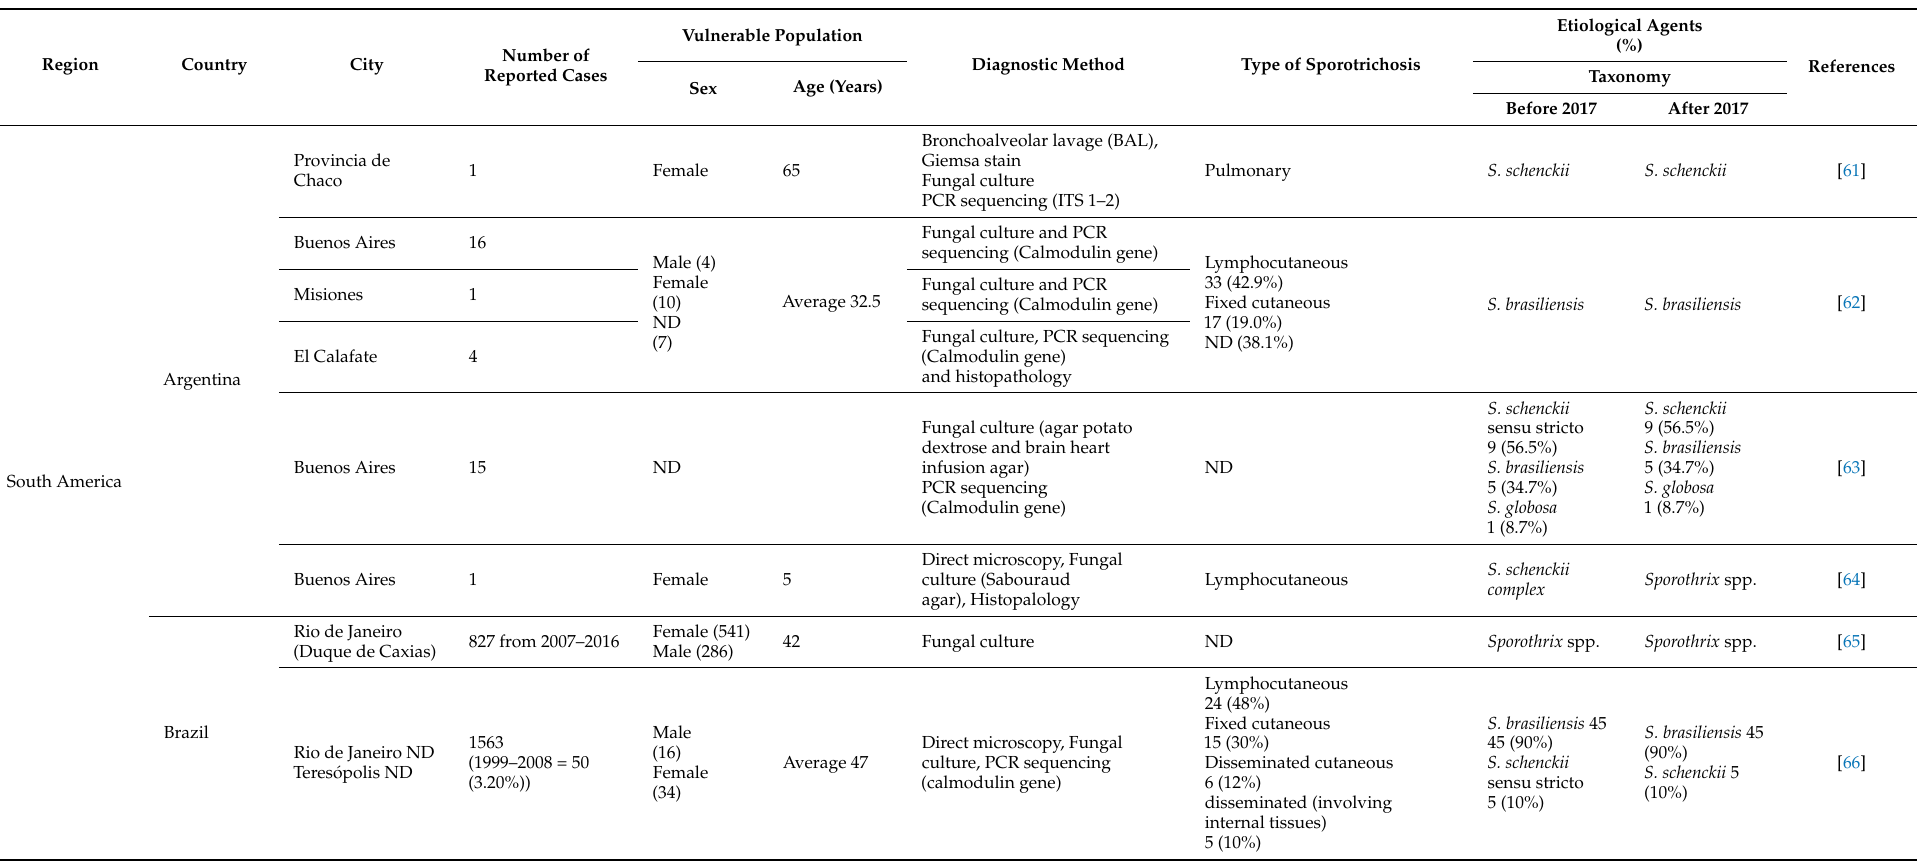
Table 3. Epidemiology of Sporotrichosis in Central America and the